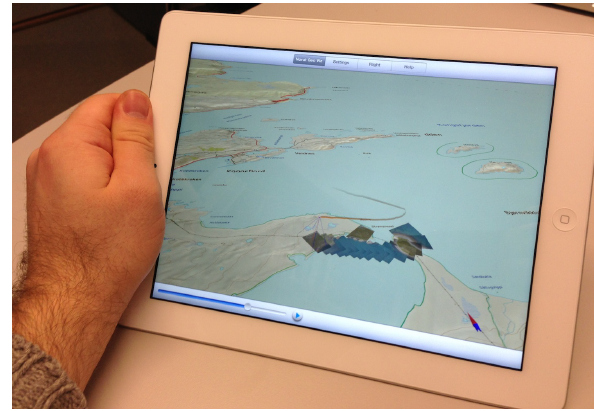
Figure 5: Norut Geo Viz running on an iPad.